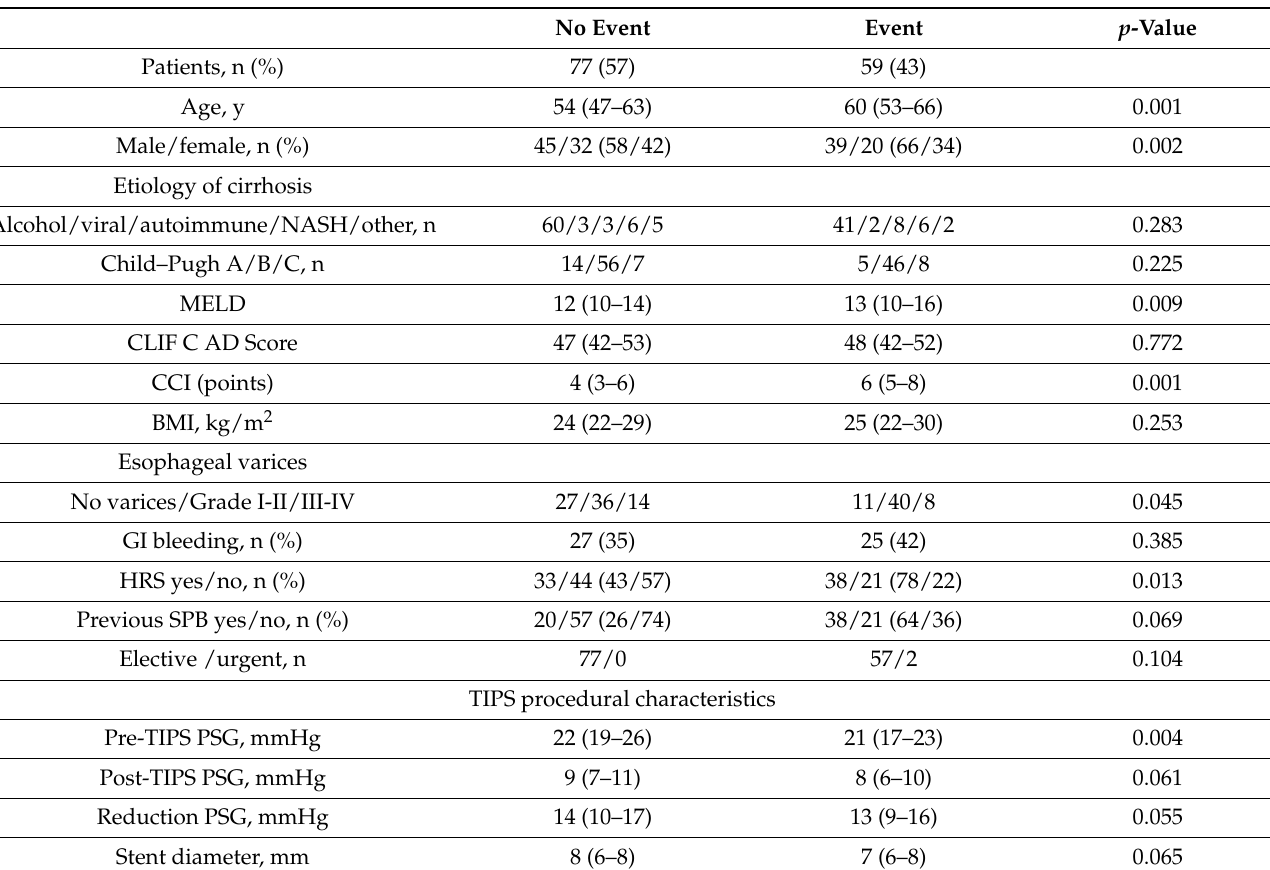
Table 4. Demographic and clinical characteristics at baseline in the groups without and with liver- related events 24 months after TIPS